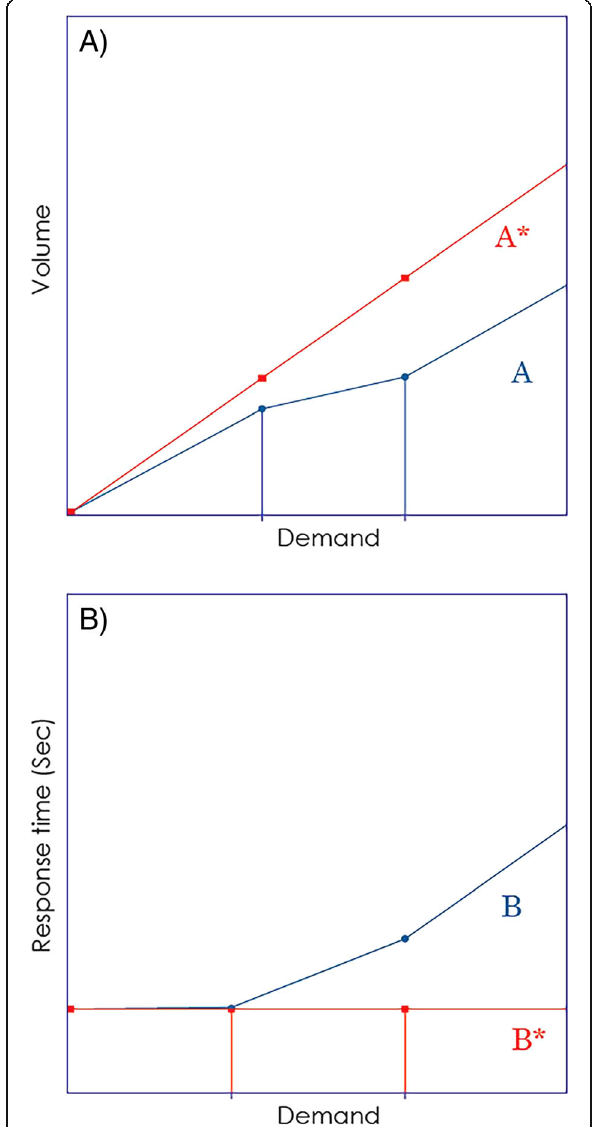
Fig. 3 The calculation of the scalability performance metrics: a the volume scalability metric is η I , which is the ratio between the areas A and A * – see Eq. (6); b the quality scalability metric is η t , which is the ratio between the areas B * and B – see Eq. (9). The red lines indicate the ideal scaling behavior and the blue curves show the actual scaling